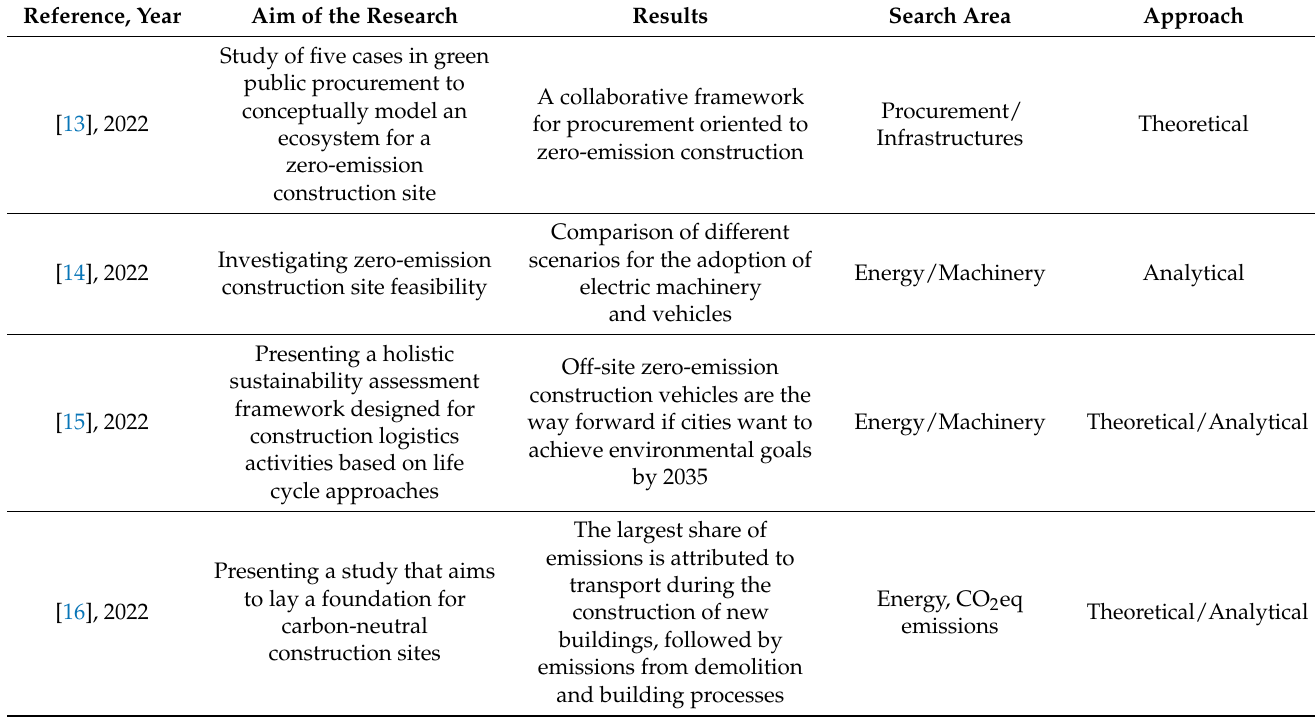
Table 1. Main references reporting the aim of the research, results, search area and